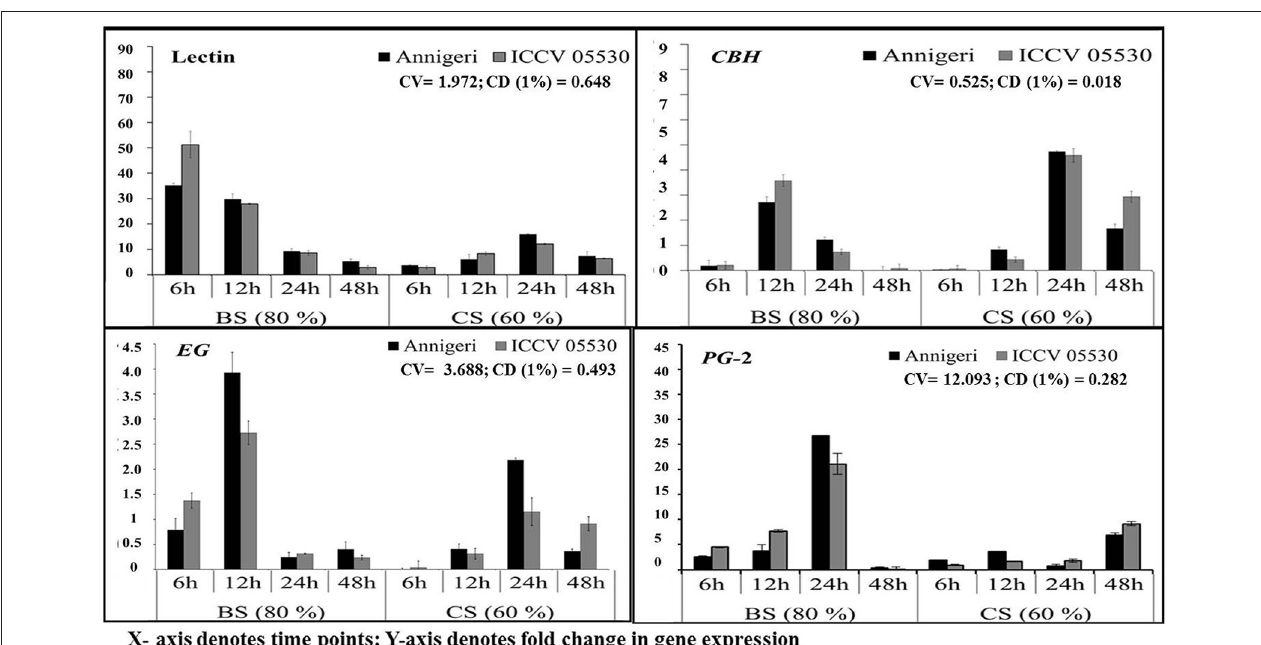
FIGURE 3 | RT-qPCR analysis of different pathogenicity-causing genes of S. rolfsii differentially expressed at lower optimum (60%) and optimum (80%) soil moisture conditions in course of infection to chickpea. Time (in hours) and fold change in gene expression are shown on X and Y axis, respectively. Standard error of three biological replications was calculated and represented as error bar. BS and CS denote biotic stress and combined stress respectively. The statistical significance of gene expression in between the control and treated seedlings was calculated by factorial